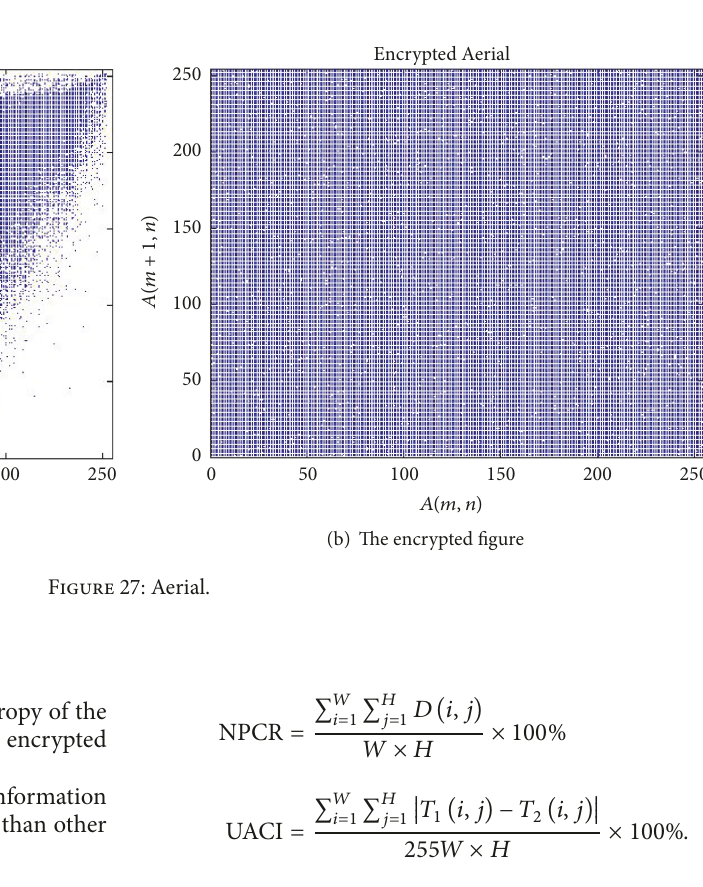
Figure 37(a) is the decrypted image with the correct keys. Figure 37(b) represents the decrypted image under 10 −16 adding to 𝑥 0 with other keys unchanged. Similarly, the